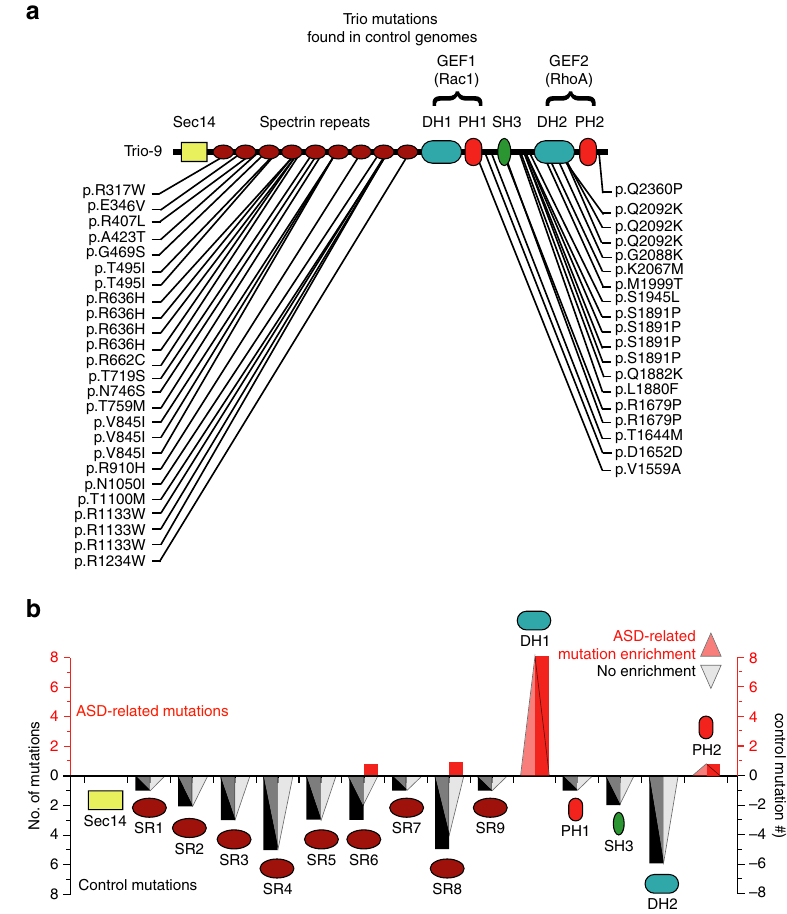
Fig. 2 Trio mutations found in control and ASD-related genomes. a Trio-9 mutations found in control genomes (from De Rubeis et al., 2014 24 ). b The graph shows the number of ASD-related ( red bars ) and control ( black bars ) mutations found in each domain of Trio-9 in individuals with ASD-related disorders and control individuals without ASD-related disorders, respectively. ASD-related Trio mutation enrichment in each domain of Trio was calculated by subtracting the number of control mutations from the number of ASD-related de novo mutations observed in each domain. Transparent triangles illustrate the presence ( red ), absence ( black ) and magnitude of ASD-related mutation enrichment in each